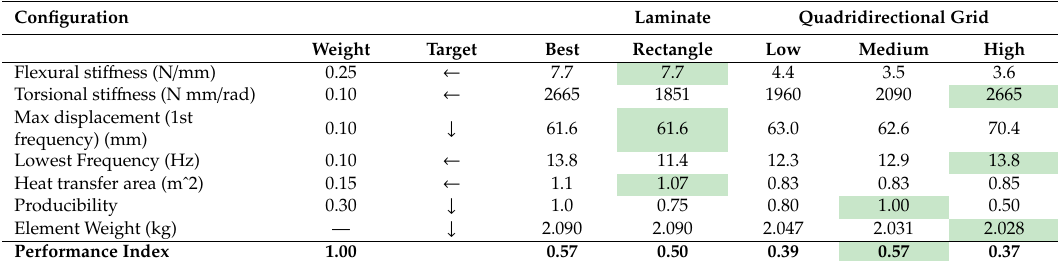
Table 9. Multi-objective optimization of composite